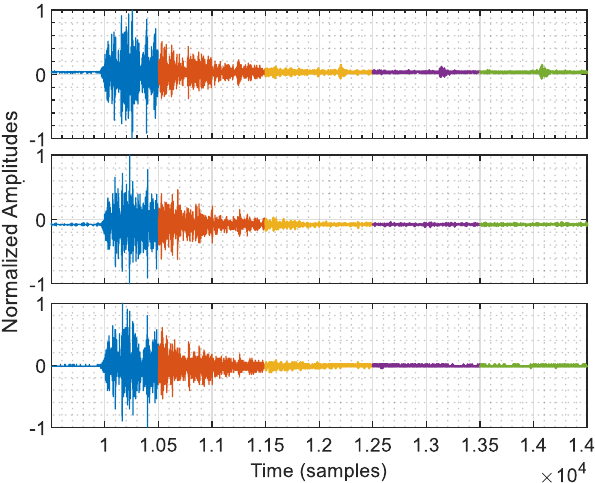
Figure 9. The VHF radiation signals associated with positive NBE received by antennae B, C, and D.